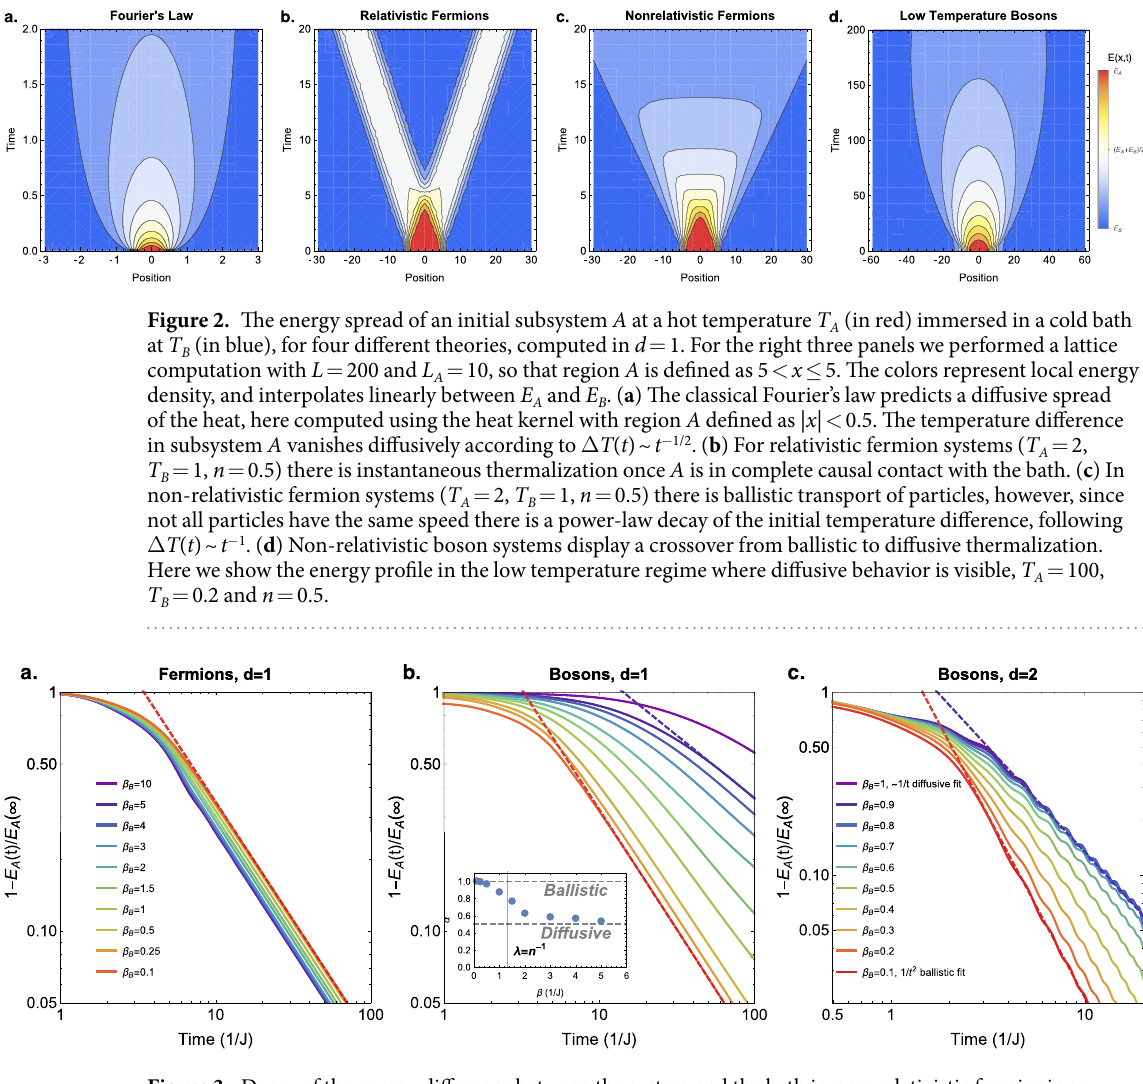
It follows that time evolution corresponds with a unitary transformation on the modular matrix. Local observ- ables as the occupation numbers and the energy are in turn functions of the equal-time Greens function at time t , ρ = ˆ ˆ † G t